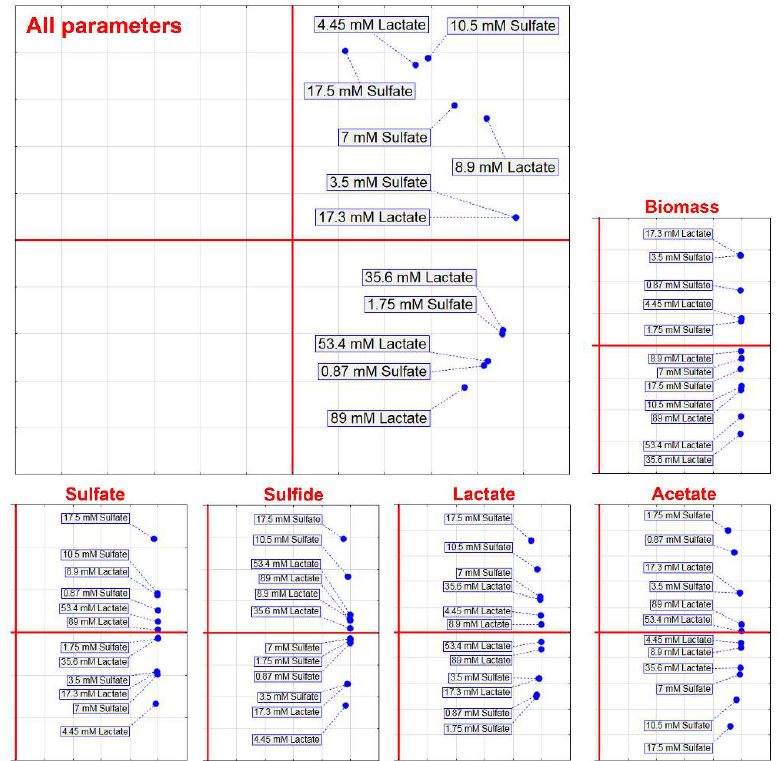
Figure 3. Principal component analysis of the D. piger Vib-7 growth and the parameters of sulfate reduction under the effect of electron acceptor (sulfate)/donor (lactate) at different concentrations.